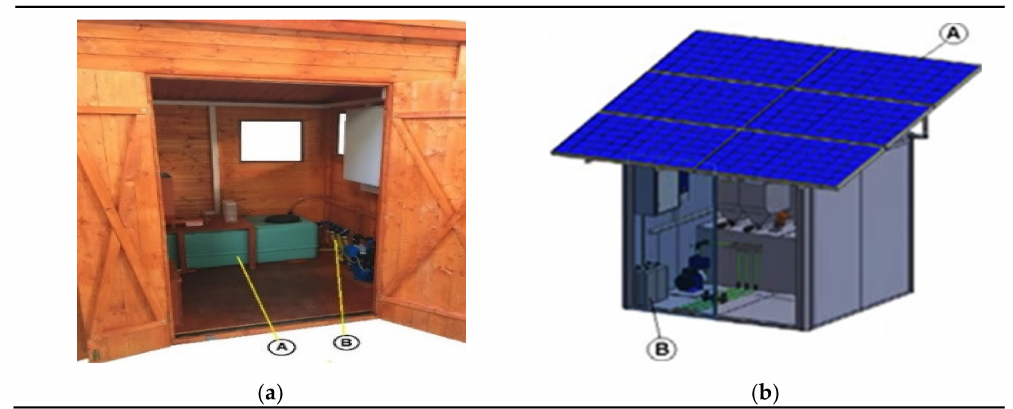
Figure 5. ( a ) Inside the realized wooden cottage with mechanical and electronic sections of the automated fertigation facility, highlighting the (A) mixing tank and (B) solenoid valves for selecting the land sectors to be irrigated; ( b ) 3D image of the solar-powered wooden cottage with the fertigation system inside, indicated by arrows the (A) solar panels positioned on the roof and (B) batteries for solar energy storage.